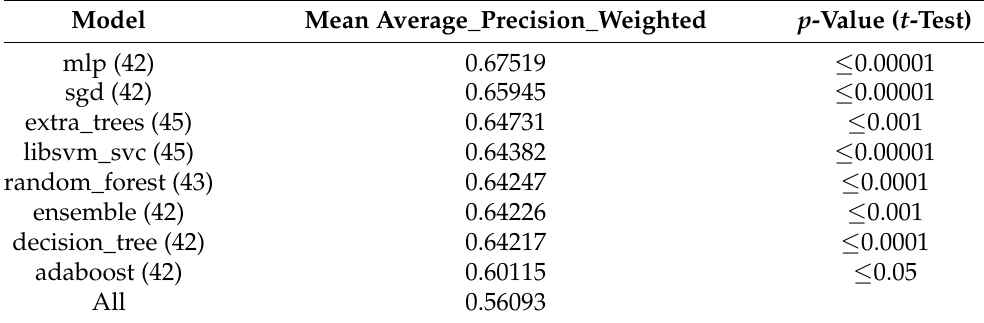
Table A4. Models with significantly better mean average precision weighted.